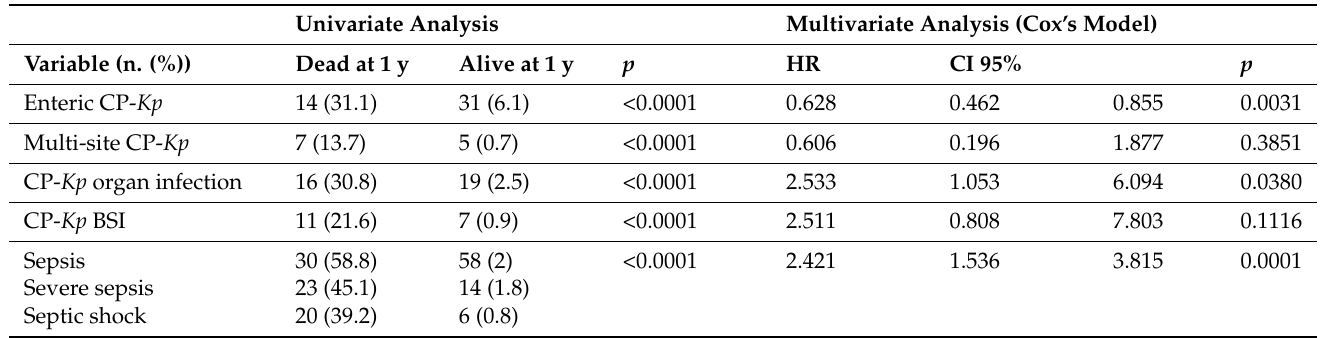
Table 3. Univariate and multivariate analysis for risk factors for 1-year mortality.